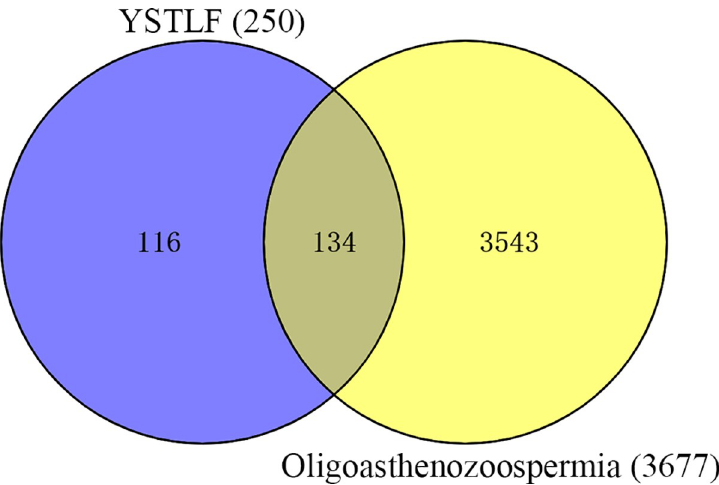
Fig 2. Venn diagram of the drugs and disease